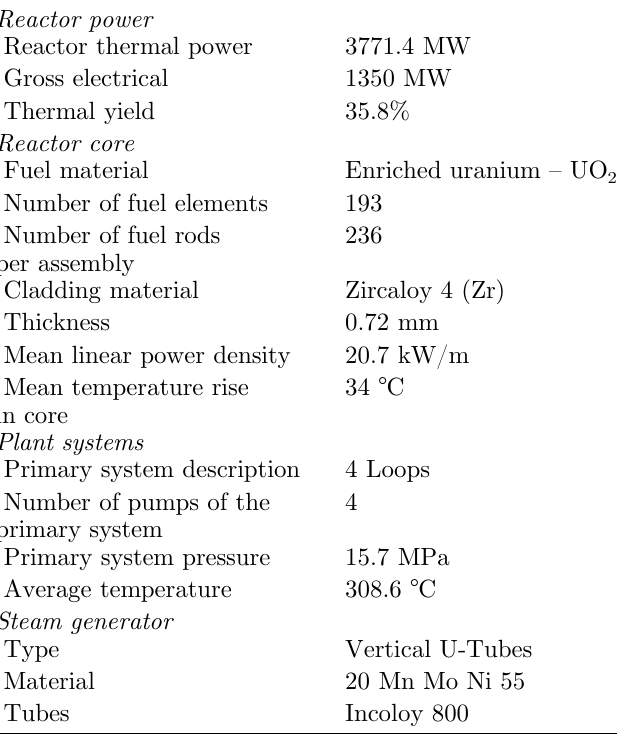
Table 1. Some technical data of the Angra 2